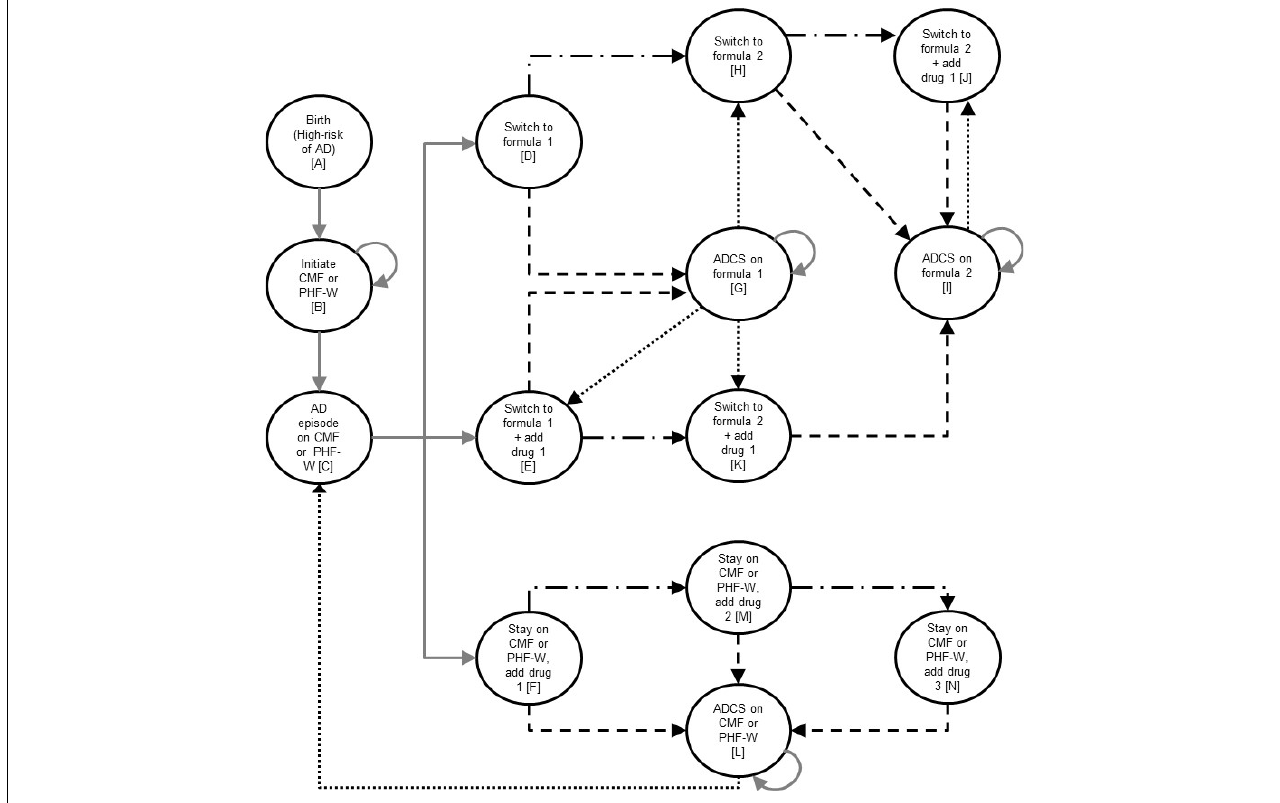
Figure 1. Simplified Presentation of the Model